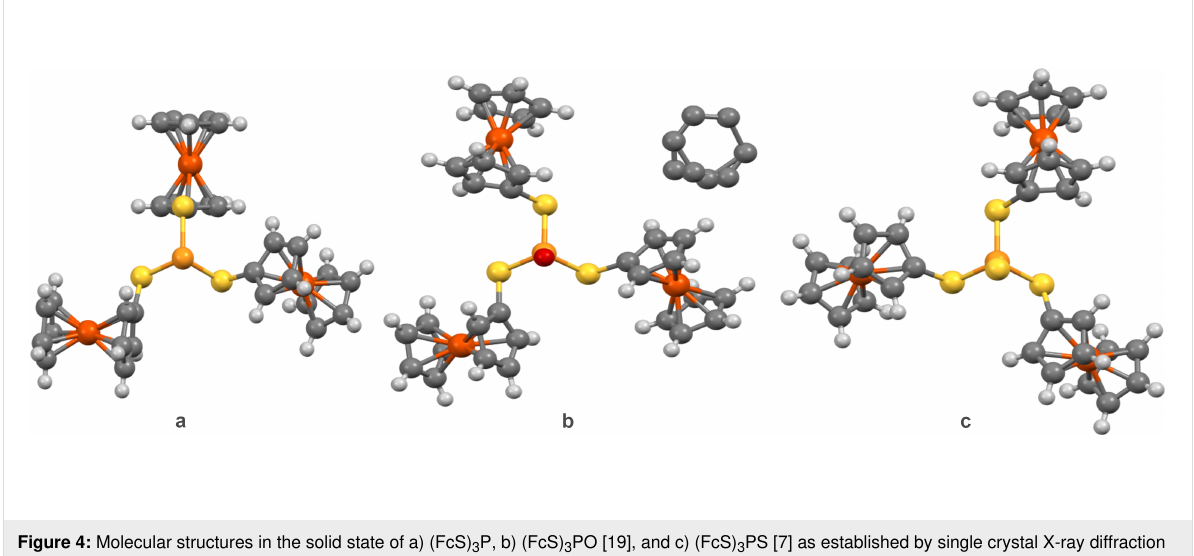
Figure 4: Molecular structures in the solid state of a) (FcS) 3 P, b) (FcS) 3 PO [19], and c) (FcS) 3 PS [7] as established by single crystal X-ray diffraction analyses. C atoms – grey, Fe atoms – brown, O atoms – red, P atoms – orange, S atoms – yellow.